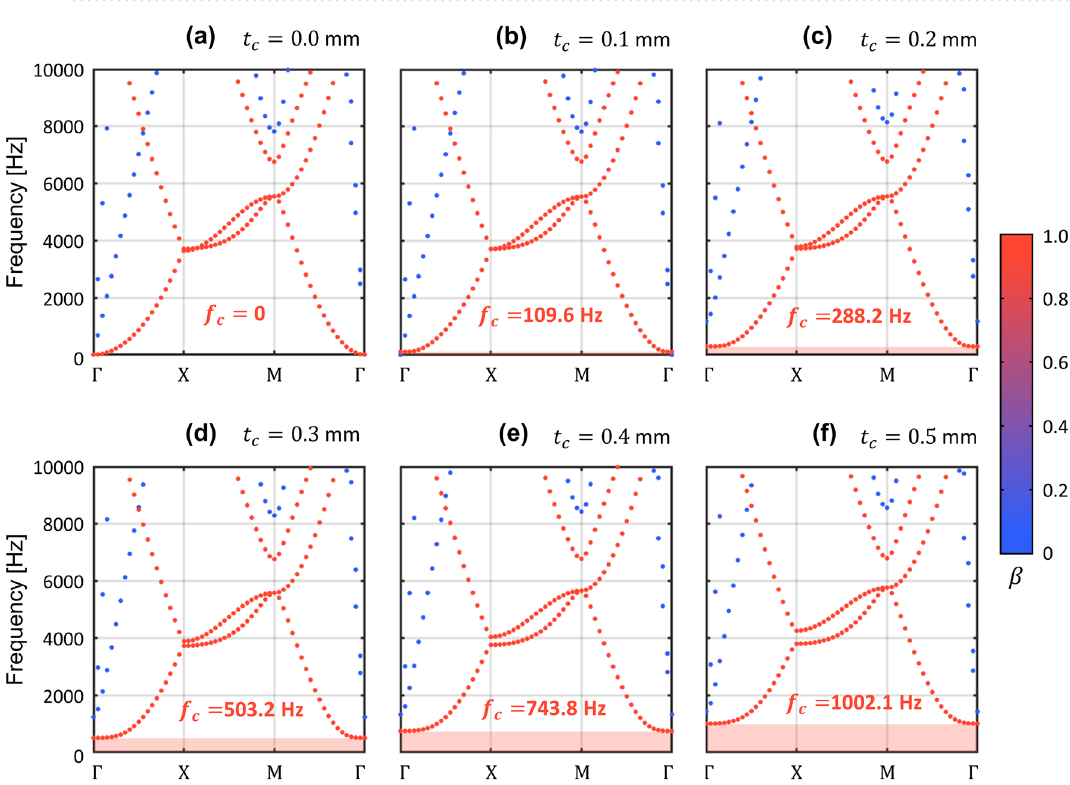
Figure 3. Band structure for varying stiffness of elastic foundation effect. The thickness of the X-shaped double bars t c is